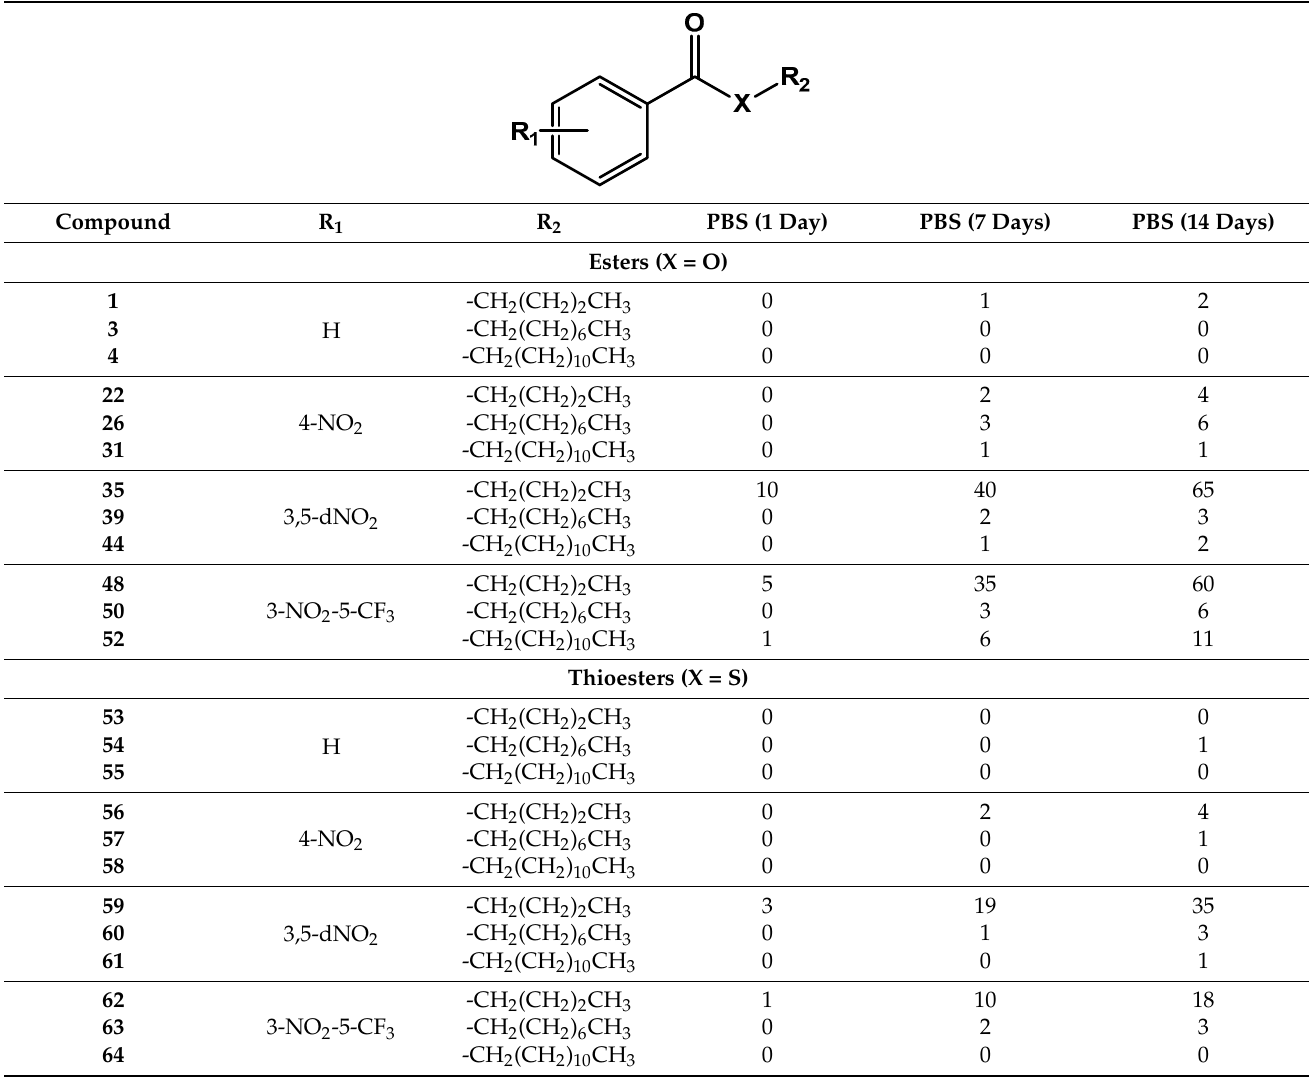
Table 3. Results obtained from stability studies in phosphate buffer (PBS). Results presented as percentage (%) of hydrolysis observed at each time point.